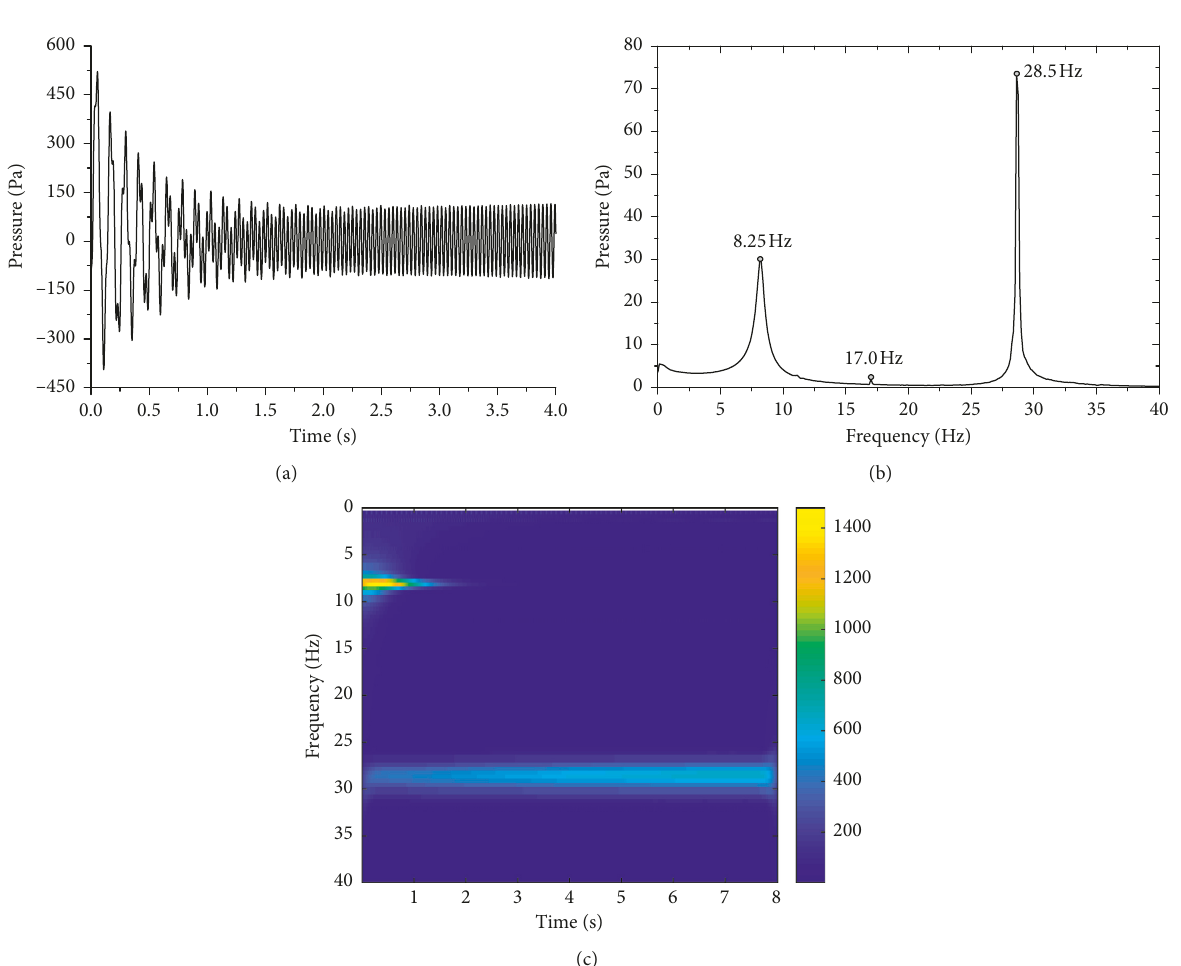
Figure 9: Calculation results of MP4 in Case 5: (a) time-domain waveform; (b) spectrum; (c) wavelet transform.